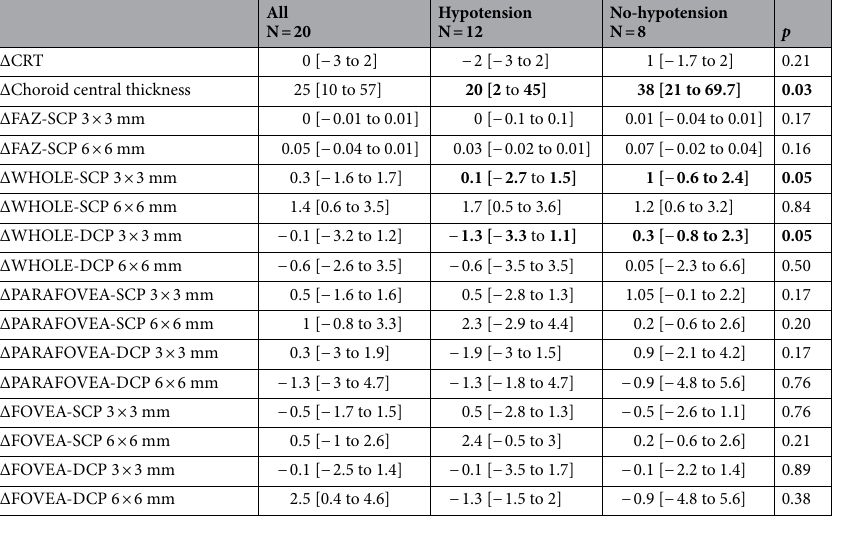
Table 2. Pre-post dialysis change (Δ) in OCT-A metrics in the whole cohort and in subgroups. CRT central retinal thickness, FAZ foveal avascular zone, DCP deep capillary plexus, SCP superficial capillary plexus. Statistically significant differences between subgroups are shown in bold.